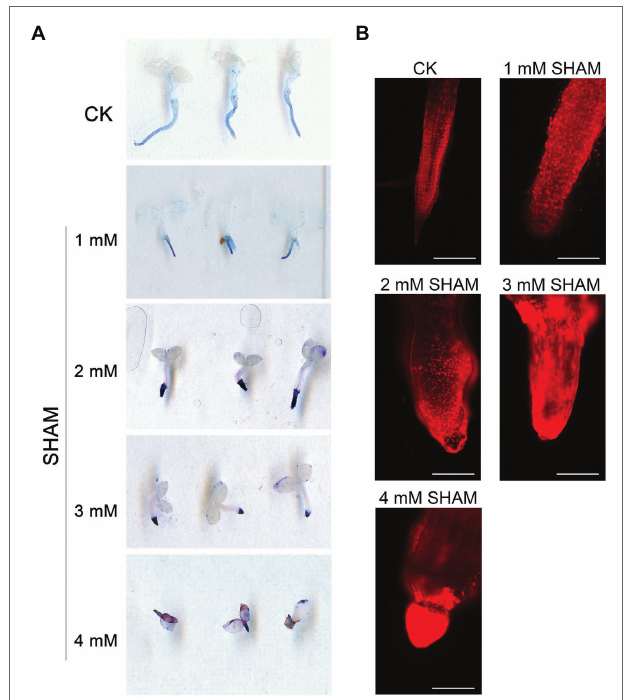
FIGURE 3 | Comparison of cell death between the SHAM-treated seedlings and the control (CK). (A) Cell death was determined with trypan blue, and the representative roots are shown. (B) The microscopic images of roots after propidium iodide (PI) staining and the representative roots are shown. Seedlings on 8th day of growth were used for trypan blue and PI staining. Scale bar, 200 μ